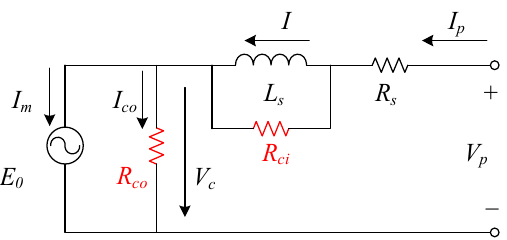
Figure 16. Proposed per-phase ECM of PMSM with accurate core loss prediction.